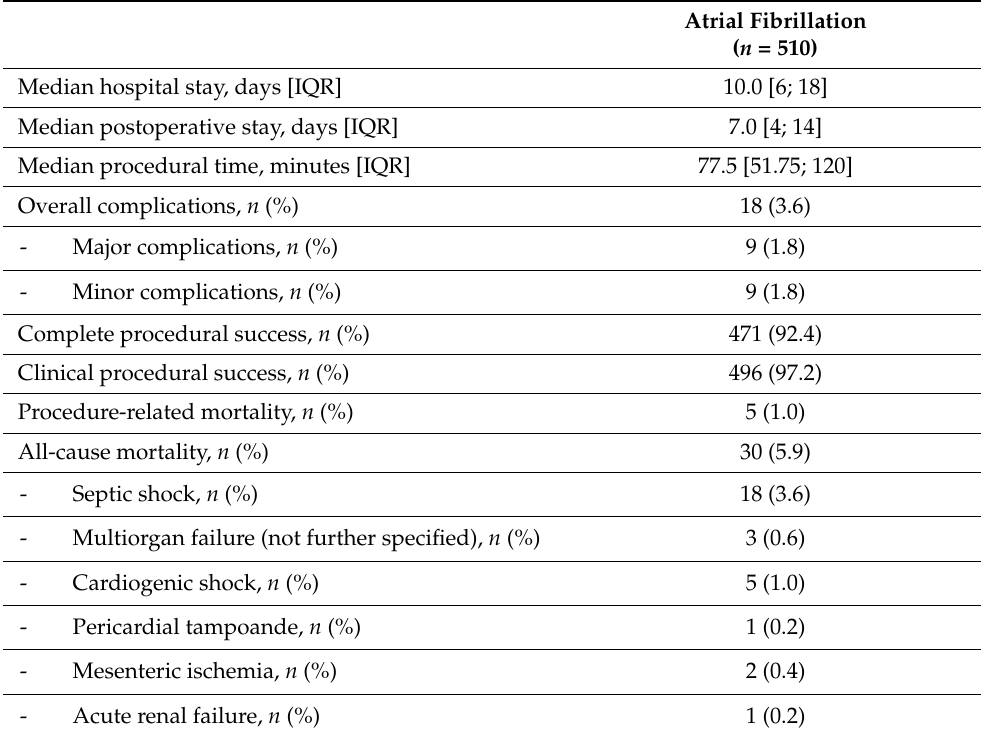
Figure 1. Pie chart depicting the various extraction indications of patients with atrial fibrillation undergoing transvenous lead extraction in percent. Table 2. Procedural